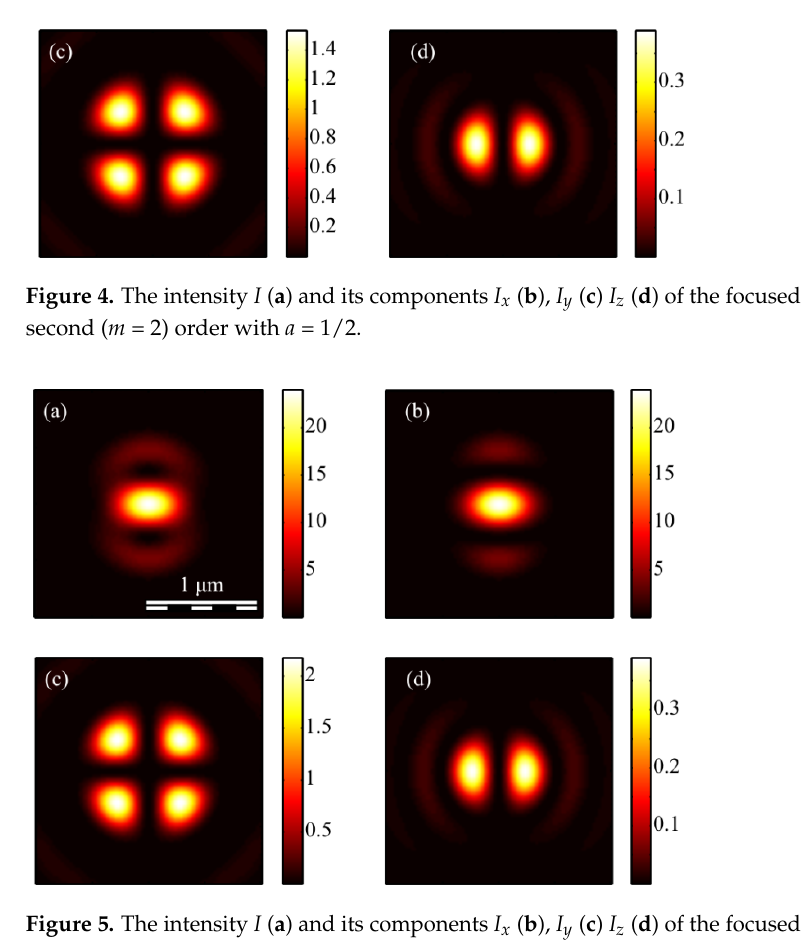
Figure 5. The intensity I ( a ) and its components I x ( b ), I y ( c ) I z ( d ) of the focused vector field (1) of the second ( m = 2) order with a =